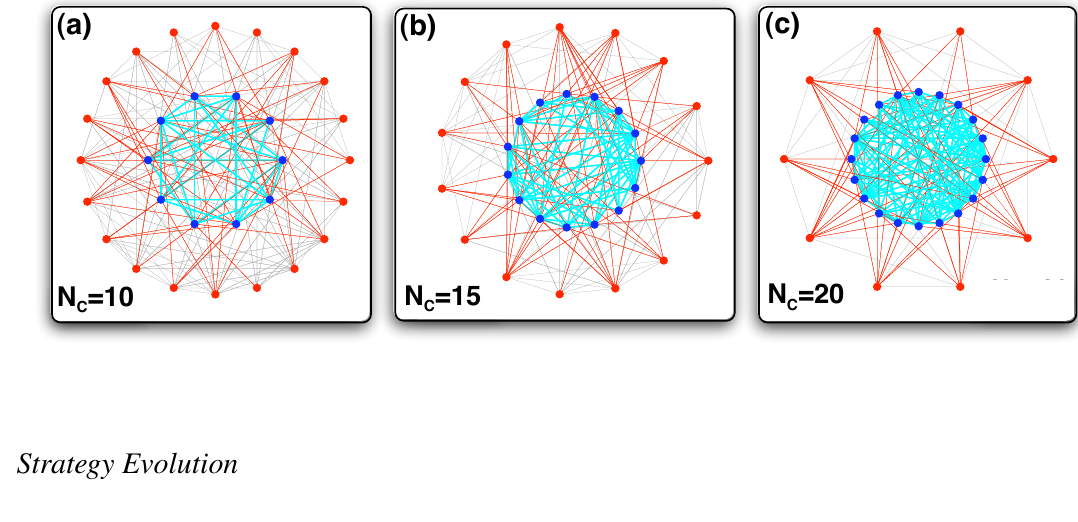
Figure 2. Frequency-dependent network evolution. Blue circles indicate C’s , red circles indicate D’s . CC -links are depicted as cyan lines, CD -links as red lines and DD -links as gray lines. Each panel shows a snapshot of a network in the steady state of the network dynamics associated with given configuration of C’s and D’s . The parameters governing the network = 0 . 5 , γ = 0 . 25 and γ = 0 . 5 . The total population size is dynamics are c = 0 . 25 , γ CC CD DD N = 30 . Figure reproduced from